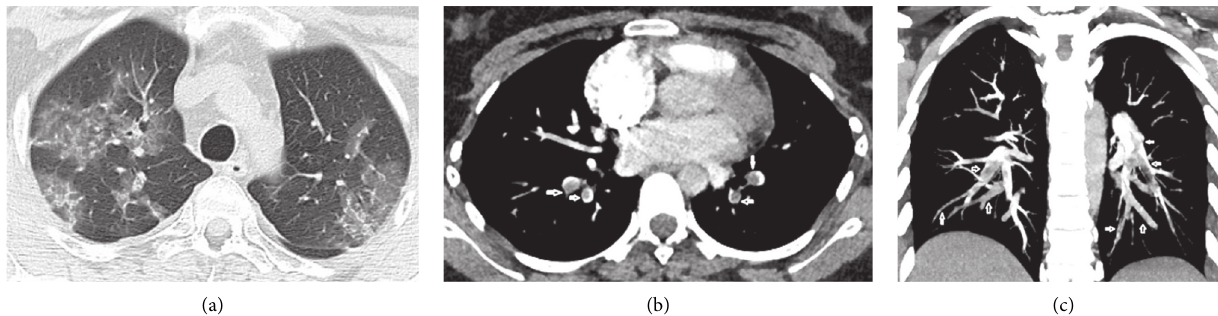
Figure 2: Images in a 22-year-old female with COVID-19 pneumonia complaining of fever, cough, and headache. (a) Axial unenhanced chest CT scan (lung window) obtained on day 6 after the onset of symptoms shows bilateral areas of central and peripheral ground-glass opacities and mixed density pattern. (b) Axial CT pulmonary angiography scan (mediastinum window). (c) Coronal thick maximum intensity projection slab of CTpulmonary angiography on day 24 after the onset of symptoms demonstrates filling defects (white arrows) in the left lower lobar as well as in both the right and left segmental/subsegmental pulmonary artery branches of the lower